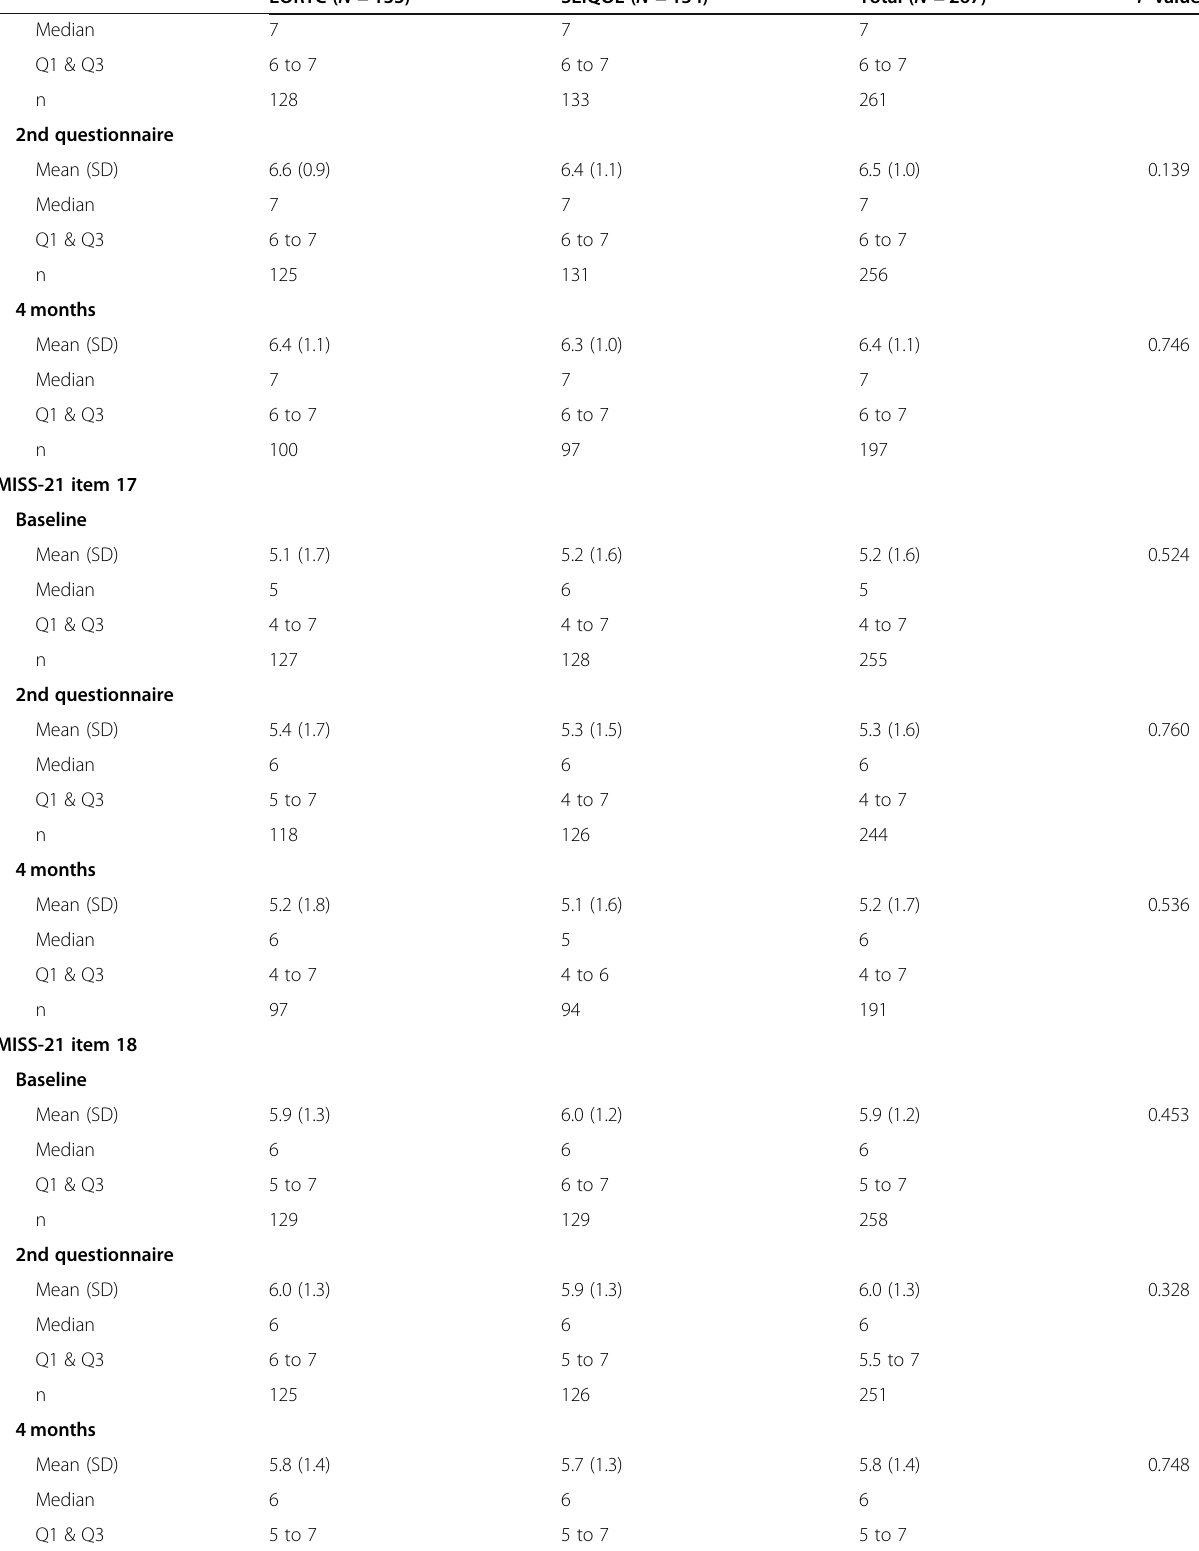
Table 2 Outcomes a over time for analyzed patients